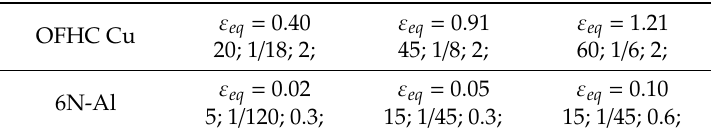
Table 1. Equivalent strain ε eq obtained by the different HPT experimental parameters for Oxygen-Free High Conductivity (OFHC) Cu and 6N-Al; ε eq calculated by rotation angle, θ °, number of turns, N , distance to disc center, r (mm) using Equation (2).